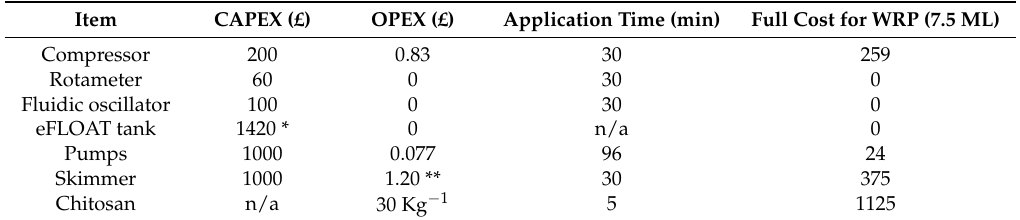
Table 2. CAPEX and OPEX of eFLOAT system based on one modular system treating 24,000 L water in 30 min. (Figures are given as a guideline